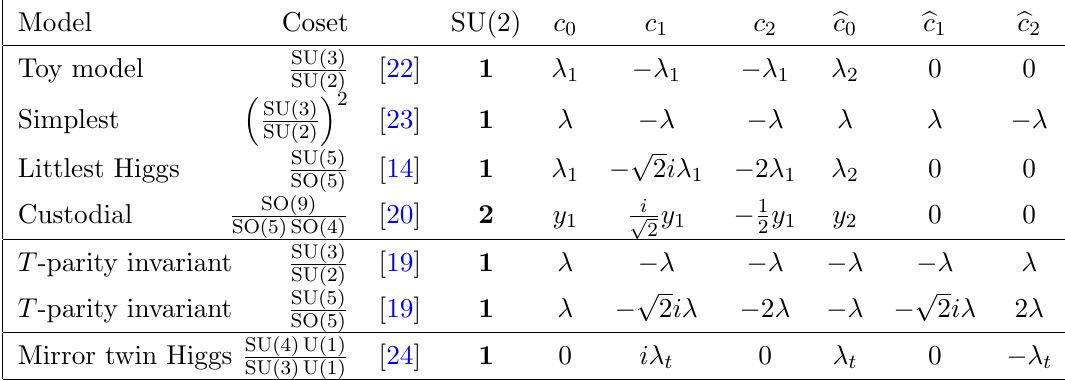
Table 1. Parameter of the couplings between top quarks, top partners and the Higgs scalar in the gauge eigenstate basis as de(cid:12)ned in Lagrangian (2.1) for some representative models. In the column labeled SU(2) we indicate if the top partners are singlets or embedded into doublets